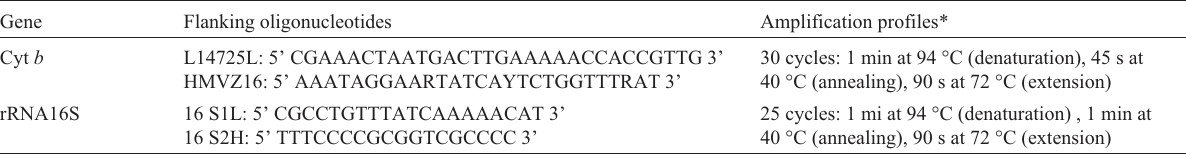
Table 1 - PCR conditions for isolating cytochrome b and 16S rRNA genes of Macrodon ancylodon. Gene Flanking